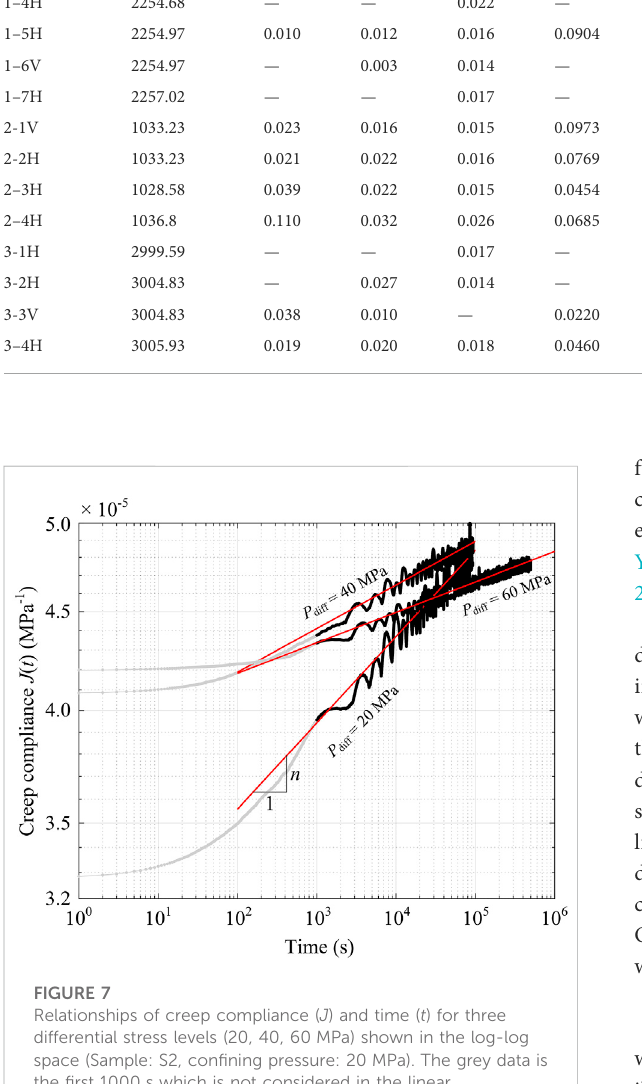
Frontiers in Earth